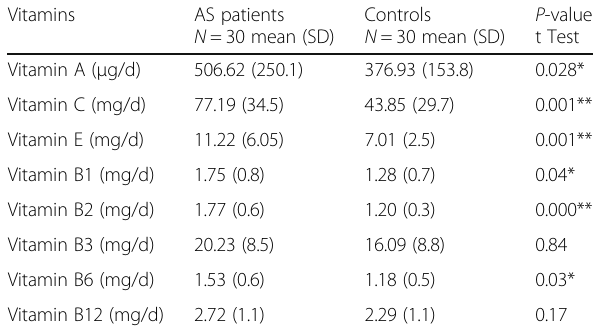
Table 3 Dietary intake of vitamins in AS and healthy groups Vitamins AS patients N = 30 mean